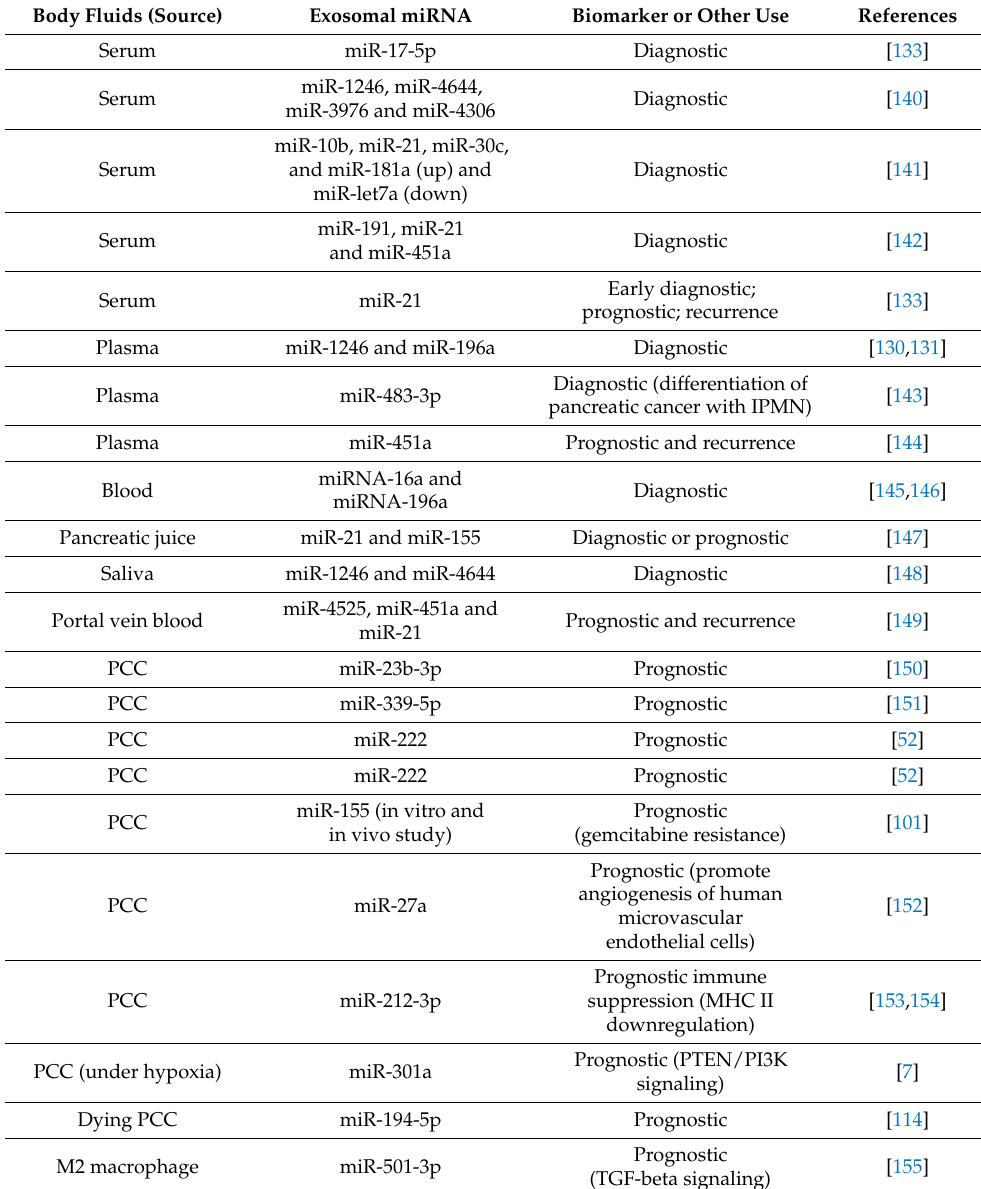
Table 1. Role of exosomal miRNAs in pancreatic